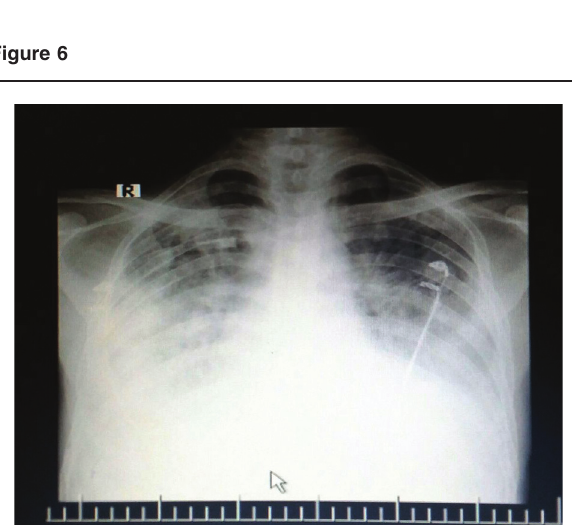
Chest radiograph showing recurrence of pulmonary